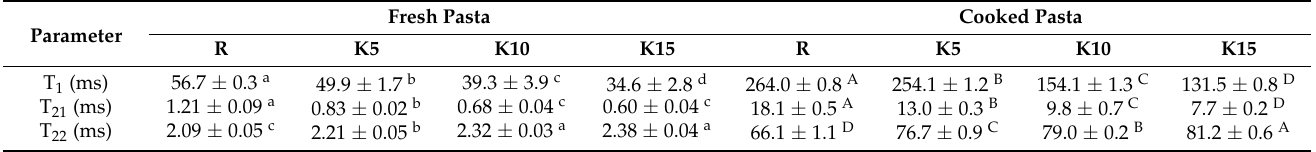
Table 5. LF NMR relaxometry results of fresh and cooked